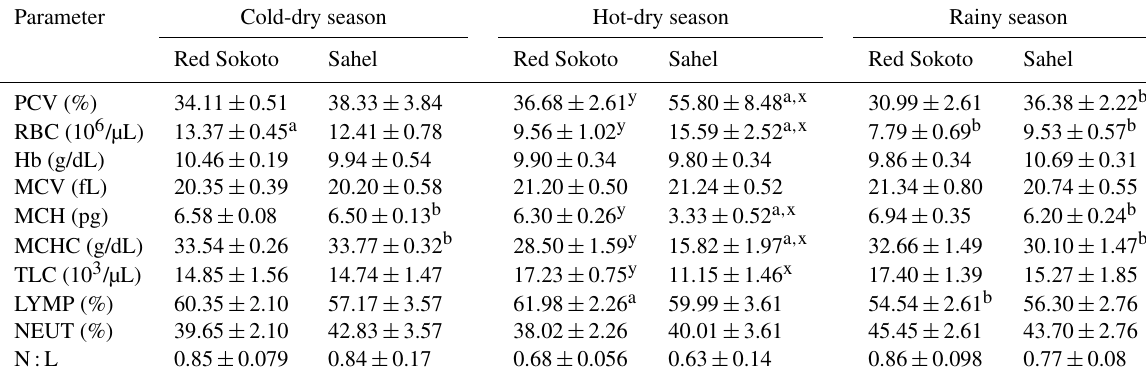
Table 3. Effect of season on haematological parameters of Red Sokoto and Sahel doe kids. Parameter